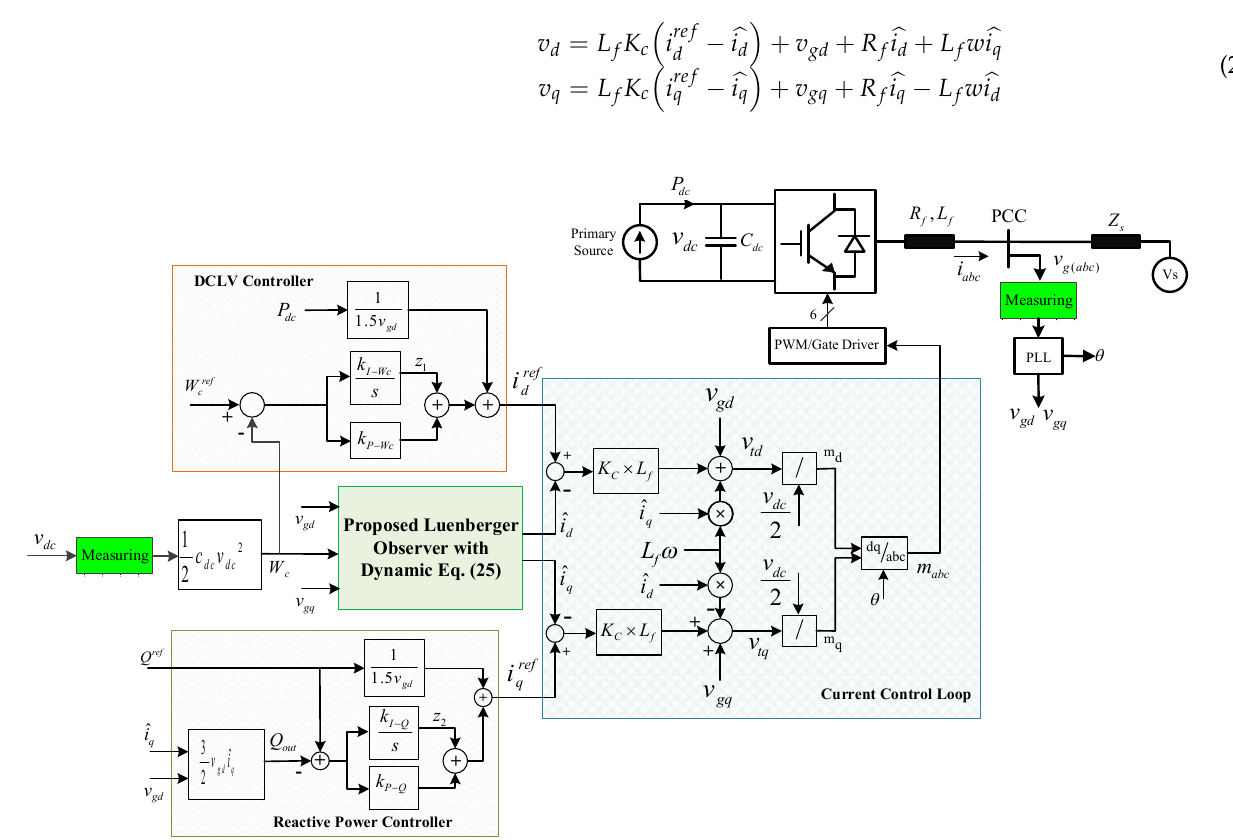
Figure 2. Complete control block diagram of a GFL-inverter including (i) the proposed observer control scheme; (ii) DCLV controller; (iii) reactive power controller; (iv) current control loop; (v) measured DC-link voltage and grid-side voltages.